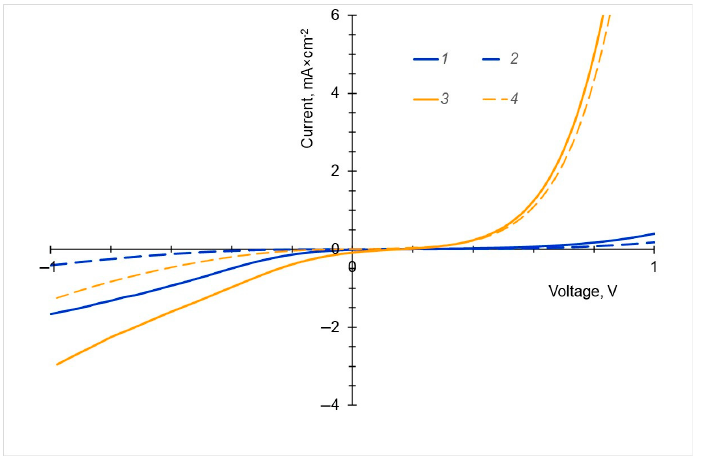
Figure 7. I ‐ V curve of photocurrent (1, 3) and dark current (2, 4) for diodes based on the Cu ‐ PP ‐ IX (1, 2) and Cu ‐ C ‐ e6 (3, 4) dyes.